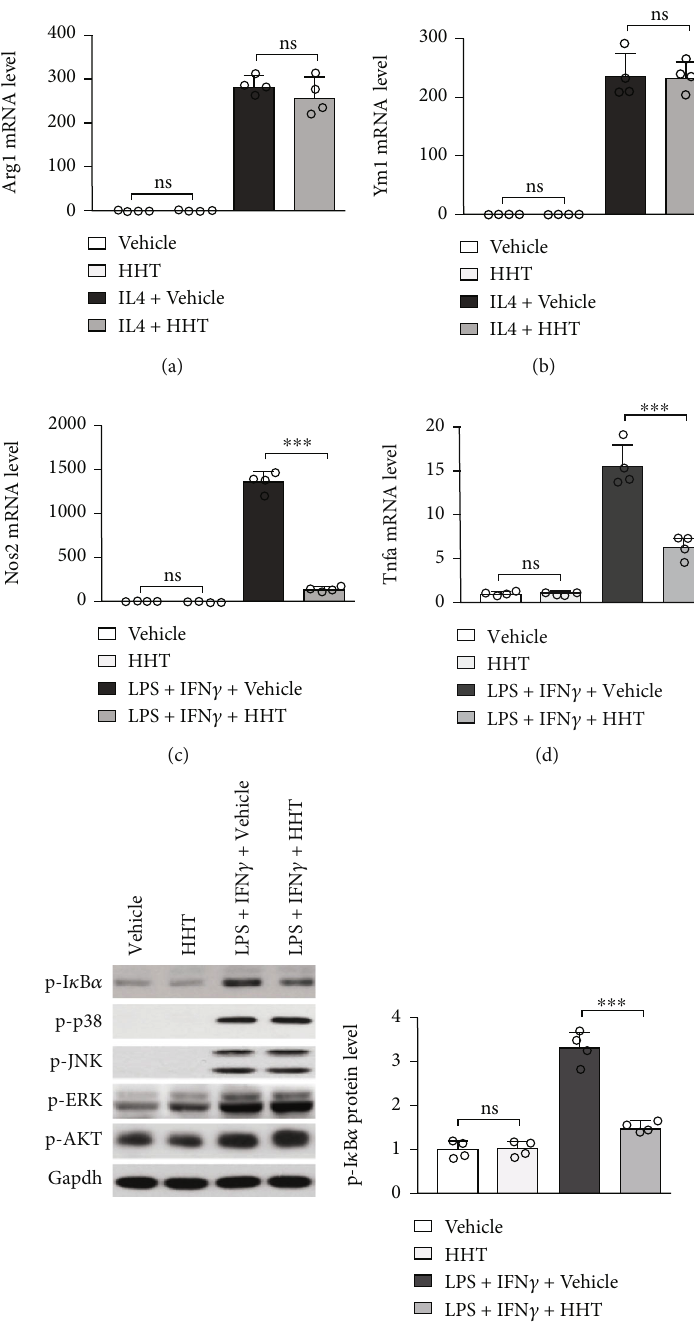
(Figure S3A) and migration (Figure S3B) ability of human colon epithelial cells in vitro .